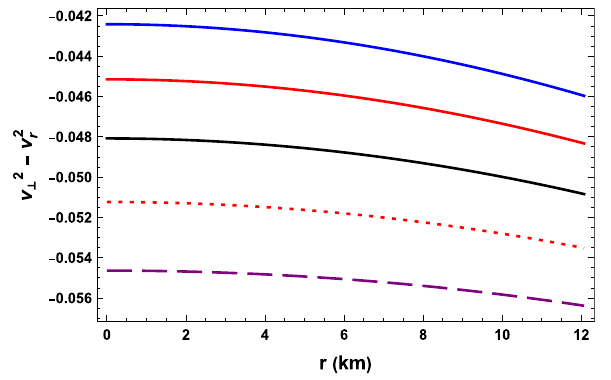
Fig. 12 Radial variation of (cid:12) ⊥ in PSR J0348+0432 for different α values in